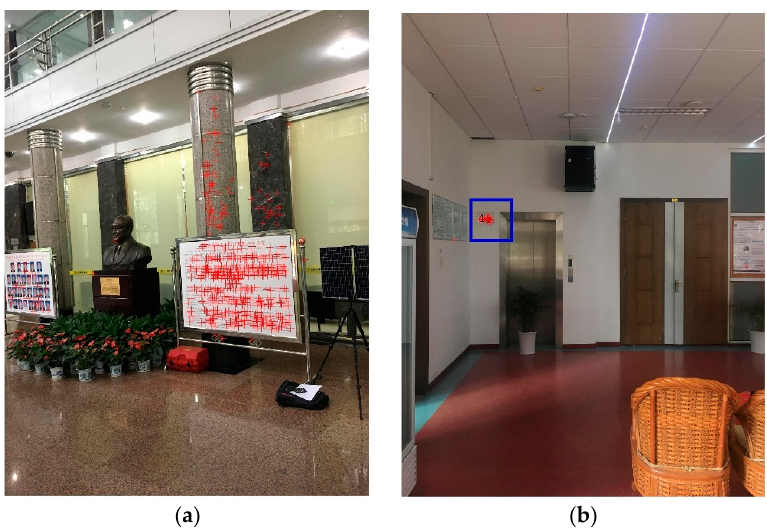
Figure 15. Distribution of feature points before PnP estimator. ( a ) Good distribution and enough feature points. ( b ) Bad distribution of feature points.